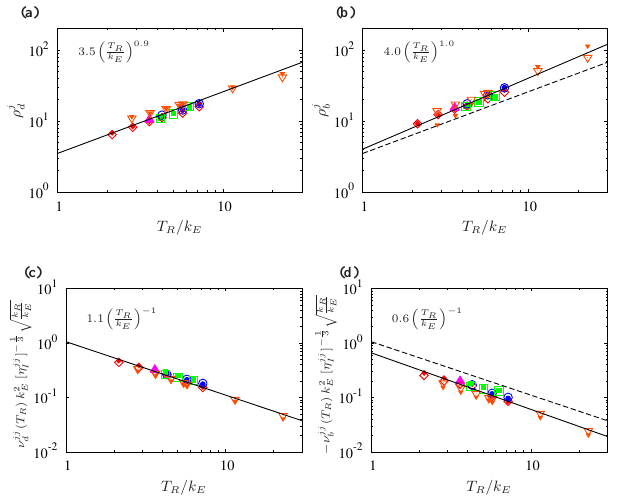
Figure 4. Scaling of the isotropic eddy viscosities. Slope of the (a) drain eddy viscosity ρ j , and (b) backscatter eddy viscosity ρ j . d b (T R ) , and (d) nega- Magnitude of the (c) drain eddy viscosity ν jj d (T R ) . The dashed lines in pan- tive backscatter eddy viscosity − ν jj b els (b) and (d) represent the drain scaling laws to serve as a di- rect comparison to the backscatter scaling laws represented by the solid lines. The symbols correspond to the various cases as follows: red diamond, k R = 142, k E = 70; blue circle, k R = 284, k E = 70; green square, k R = 142, k E ∈ ( 40 , 50 , 60 ) ; magenta upward point- ing triangle, k R ∈ ( 201 , 246 ) , k E = 70; orange downward pointing triangle, k R = 14, k E = 11 (atmosphere). Filled symbols represent j = 1 and hollow symbols j =